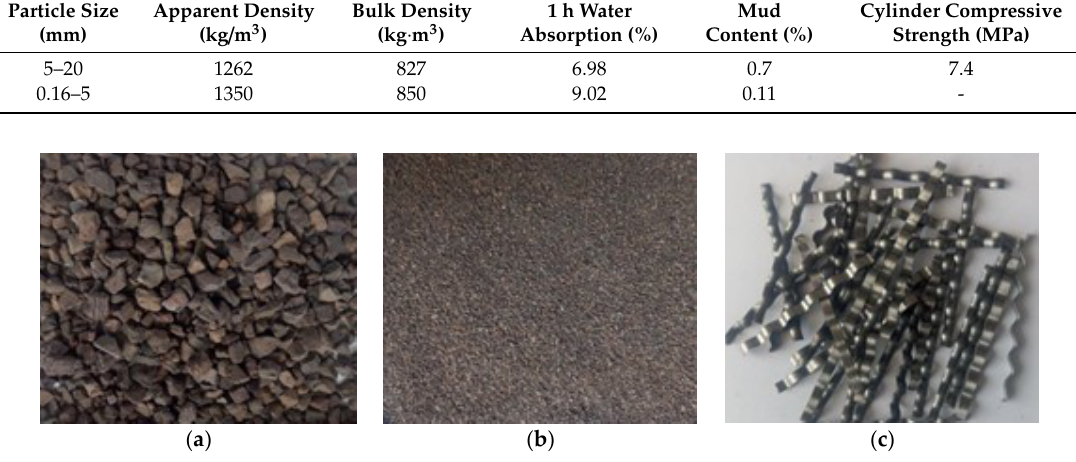
Figure 1. Figures of raw materials: ( a ) coarse expanded-shale; ( b ) ceramsite sand; ( c ) steel fiber.